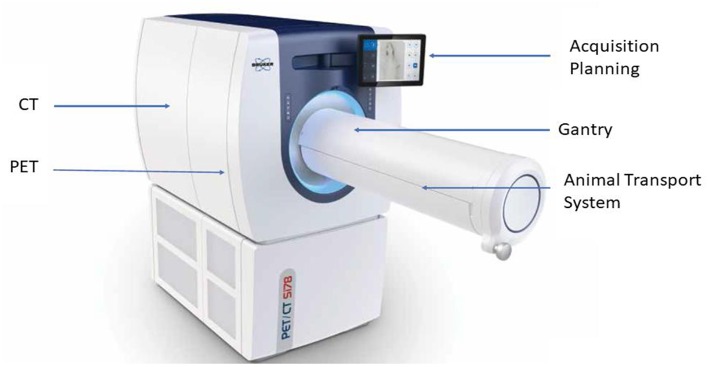
The new PET/CT “Si78”.